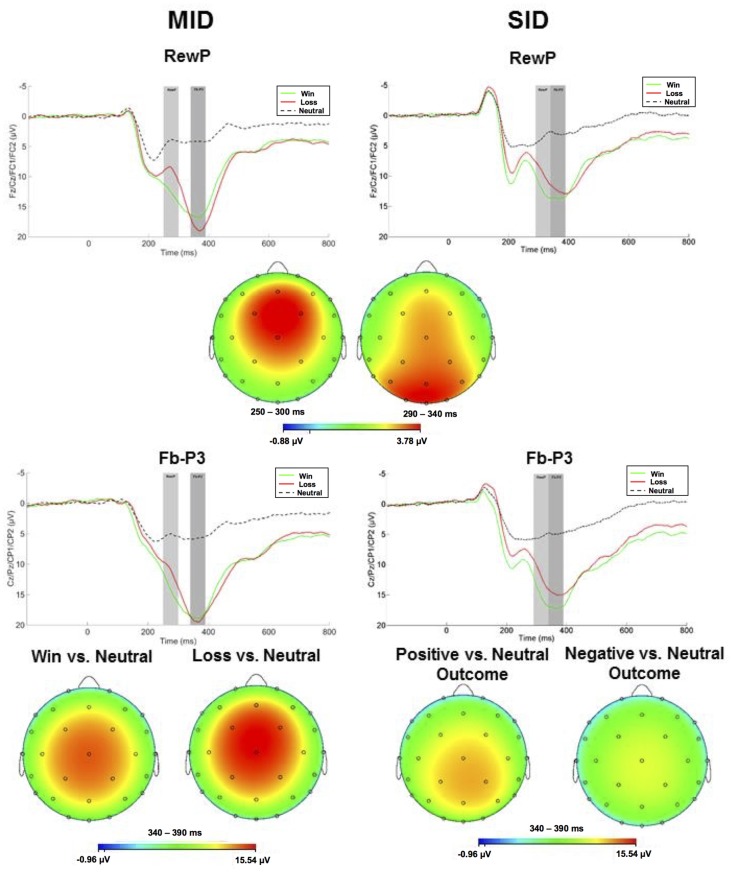
Left column: ERP responses to monetary wins, losses, and neutral outcomes on MID. Feedback onset was at 0 ms. The RewP was scored as the average activity in the first shaded window (top row: 250–300 ms) and the fb-P3 in the second shaded window (bottom row 340–390 ms). Right column: ERP responses to positive, negative, and no social feedback on SID. The RewP was scored as the average activity in the first shaded window (top row: 290–340 ms) and the fb-P3 in the second shaded window (bottom row: 340–390 ms). Scalp distributions of the difference between conditions for the RewP (positive minus negative outcome) and fb-P3 (positive minus neutral; negative minus neutral) are depicted below each waveform for MID and SID.